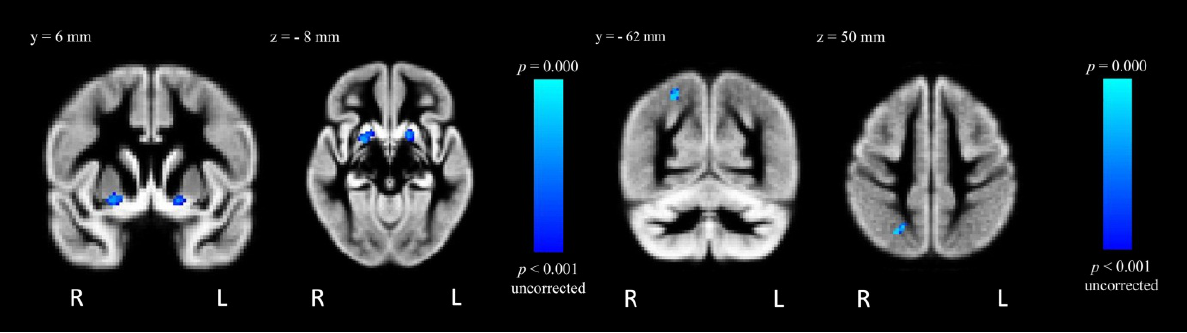
Figure 4. FSL-VBM results from the contrast “MA > Control”, where GMD is greater for MA-dependent in comparison to control participants within the right and left putamen (left) and right superior lateral occipital cortex (right), p